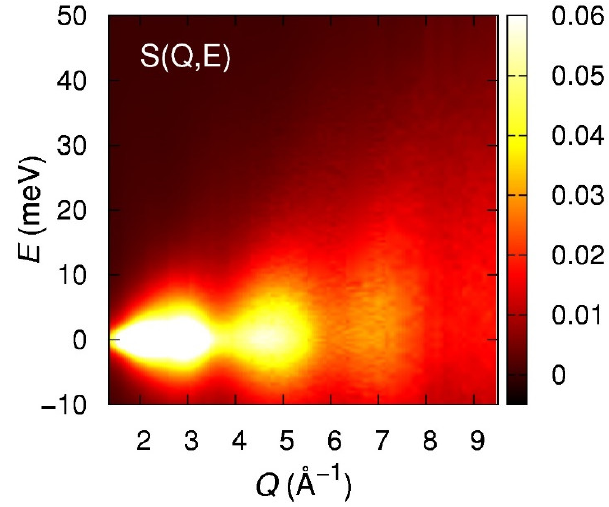
Figure 6. Dynamic structure factor, S ( Q , E ), for water at room temperature determined by inelastic X-ray scattering [32].